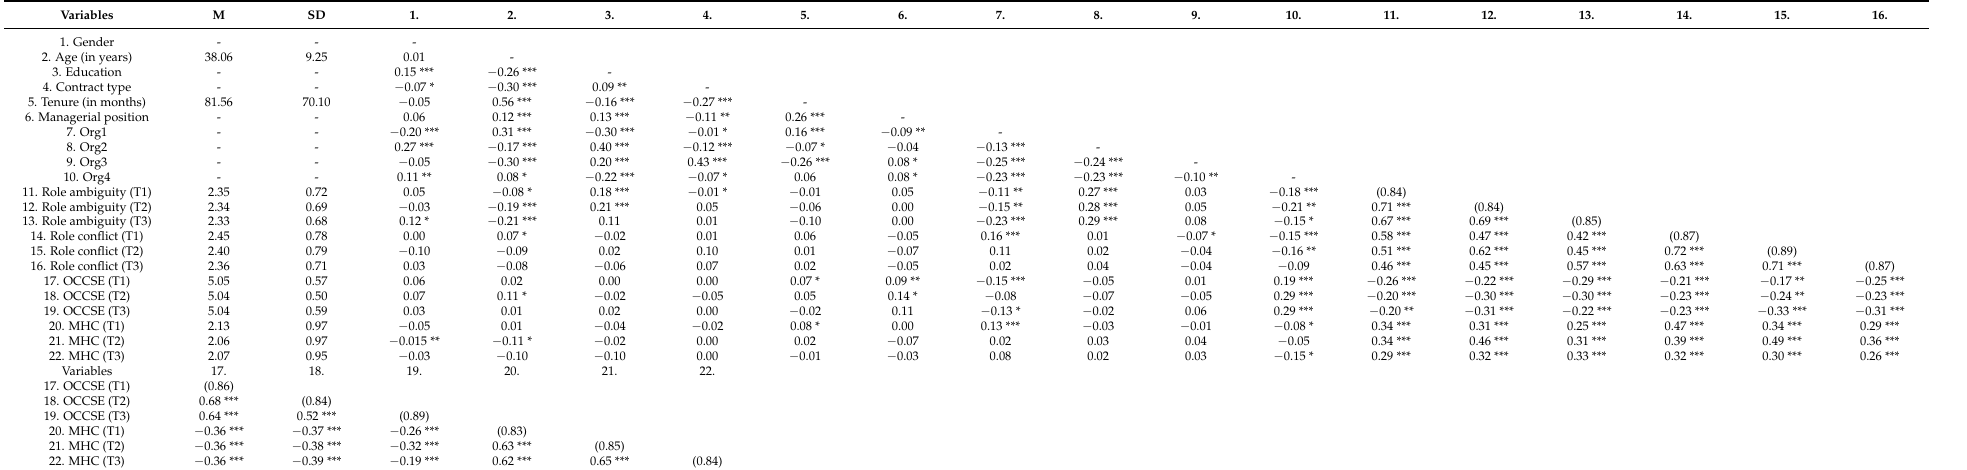
Table 1. Descriptive statistics, correlations, and Cronbach’s alpha coefficients (in